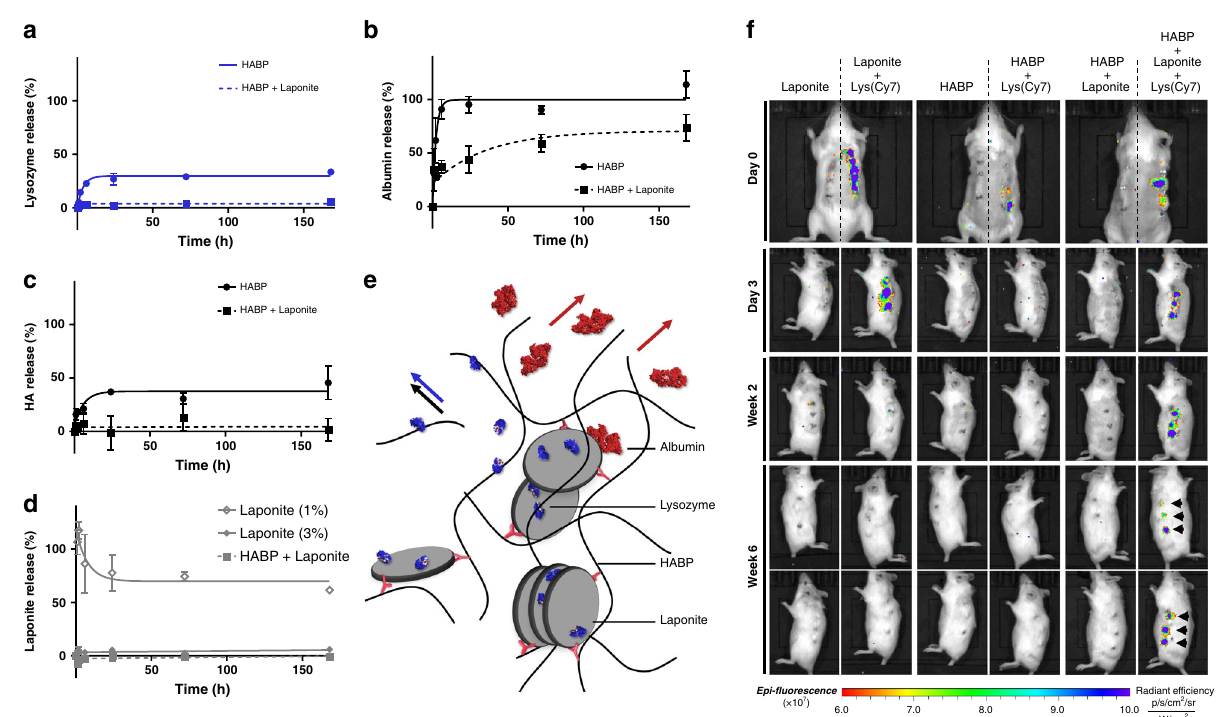
Fig. 5 Bisphosphonate-tethered Laponite sustains retention of model proteins. In vitro release pro fi les of lysozyme ( a ), albumin ( b ), and HA ( c ) from hydrazone cross-linked HABP hydrogels with and without Laponite revealed subdetectable or slowed release with addition of Laponite. Release of Laponite (1%) from HABP hydrogels was compared with 1% and 3% Laponite which present as a solution and gel, respectively ( d ). Hydrogels were incubated in PBS at 37 °C over 7 days incubation. Calculated lower limits of detection for lysozyme, HA and Laponite were 15%, 6.5% and 8.9%, respectively. Error bars = standard deviation ( n = 3). e Schematic highlights possible modes of Laponite interaction and release of albumin (red arrows), lysozyme (blue arrow) and HA (black arrow)). f In vivo release of Cy7-labeled lysozyme from Laponite, HABP, and HABP + Laponite hydrogels after subcutaneous implantation. Negligible Cy7-labeled lysozyme was detected around HABP gel 3 days after implantation, while the lysozyme incorporated into HABP + Laponite gels showed a strong Cy7 dye intensity even 42 days (6 weeks) after Methods Preparation of physical hydrogels . Physical hydrogels were prepared by inter- action of HA derivatized with BP groups and Laponite nanoparticles. Two types of HA-BP derivatives were used in which BP groups were linked either through disul fi de bonds (HA-SS-BP) or by thiol-ene addition to HA-SH derivative yielding multiple BP ligand attachments (HA-BP n ) 24,25 . Full methods for the preparation of HA derivatives are provided in Supplementary Information and Supplementary Fig. 6. Structural characterization of HA-SS-BP derivative was performed by 1 H- NMR. DS with BP groups was calculated by comparative integration of HA acetamide peak and the ten methylene protons peaks 23 . For fabrication of hydrogels of 0.3mL by volume, 150 μ L 4% solution of HA-BP derivative in water was mixed with 150 μ L of freshly prepared solution of Laponite at either 4% or 2% concentration to generate composite hydrogels of 96% and 97% water content, respectively. The mixed solutions were transferred into 2mL syringes, sealed with Para- fi lm to prevent evaporation and kept overnight for gelation. The formed hydrogels of cylindrical shape (with 8mm diameter) were removed from the syringe molds. HA concentration in the hydrogels was 2%, whereas Laponite concentration was 2% or 1%. Control experiments were also performed in which HA-BP derivatives were substituted with native HA. The in fl uence of pyropho- sphate ions on gelation was studied by preincubation of 8% Laponite solution with equal volume of 0.3M Na 4 P 2 O 7 × 10H 2 O solution for 1h prior to the mixing with HA-BP derivative. Similarly, for the study of magnesium ions on gel properties, 6% solution of HA-BP derivative (100 μ L) was preincubated with 0.4M solution of MgCl 2 (50 μ L) prior to the mixing with Laponite solution. Preparation of chemically cross-linked hydrogels . Hydrazone cross-linked HA hydrogels with or without Laponite were prepared by mixing hydrazide and aldehyde-modi fi ed HA derivatives. Four types of hydrogels were obtained: (1) HA hydrogel without attached BP groups (HA gel), (2) HA hydrogel without attached BP groups and with encapsulated Laponite NPs (HA + Laponite gel), (3) HA hydrogel with attached BP groups (HABP gel), (4) HA hydrogel with attached BP groups and with encapsulated Laponite (HABP + Laponite gel). Common aldehyde-modi fi ed HA derivative (HA-al) was used for all four types of the hydrogels. To obtain the hydrogels from groups 1 and 2, hydrazide-modi fi ed HA